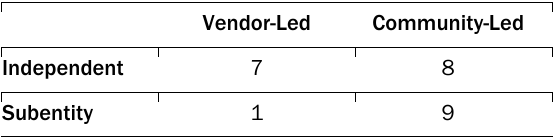
Table 1. Ownership of Market